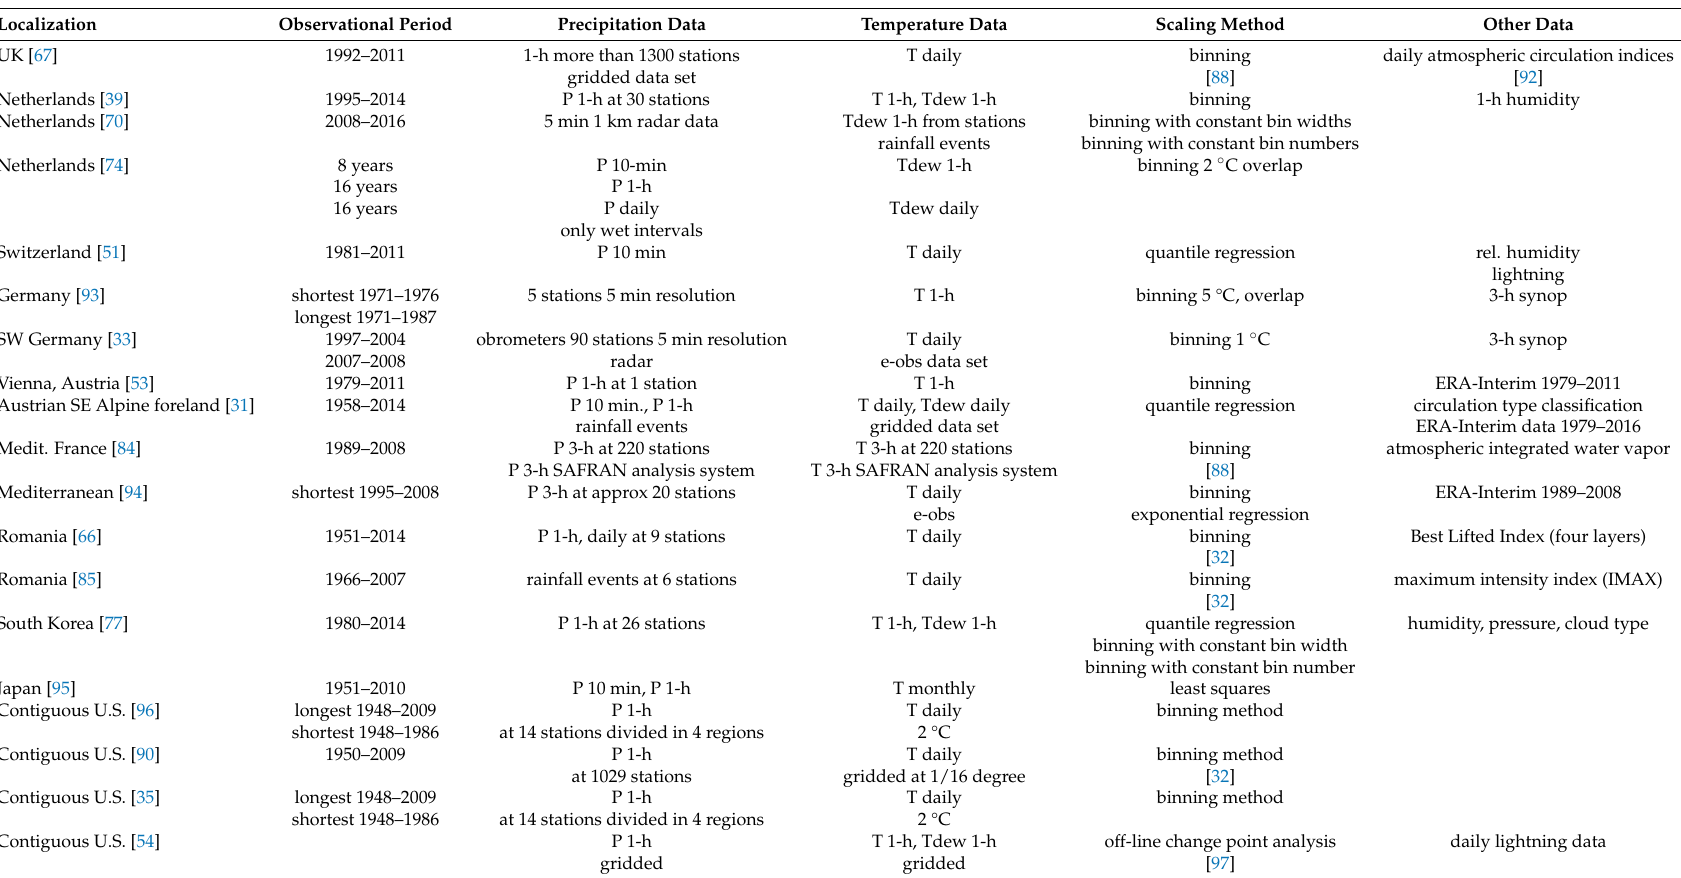
Table 2. Overview of methods and data sets used by precipitation-temperature observational studies in